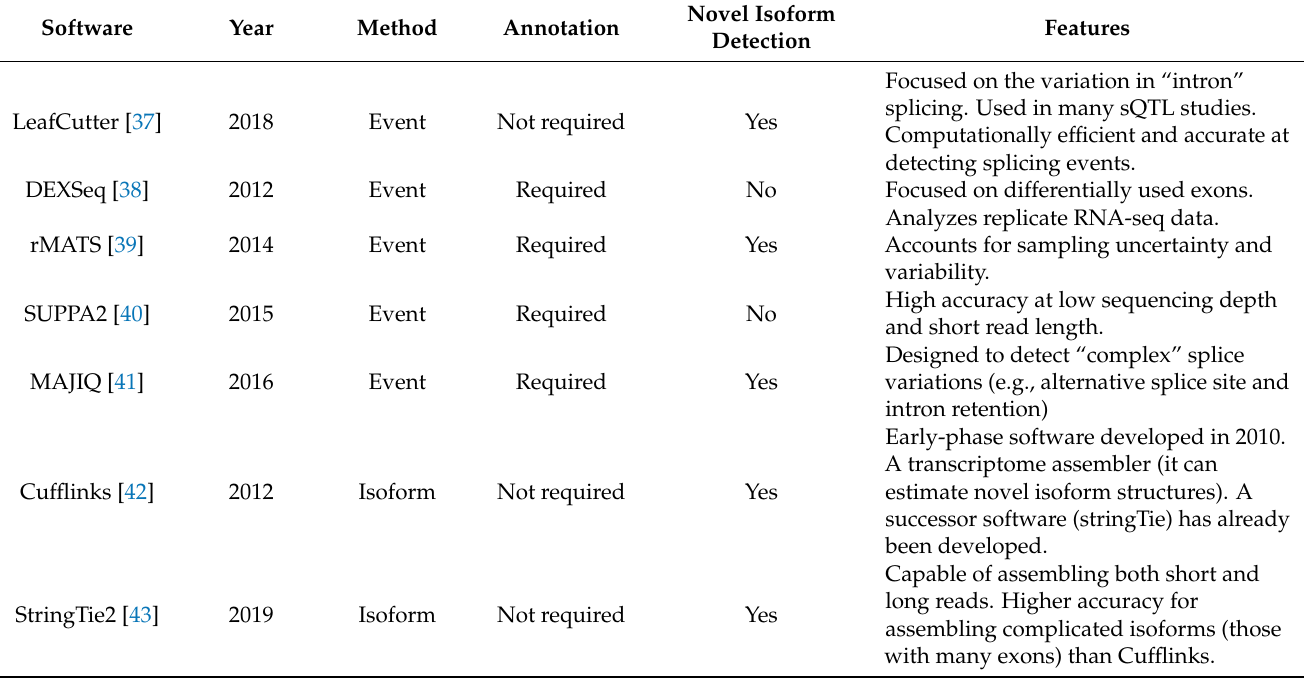
Table 1. Software for splicing isoform